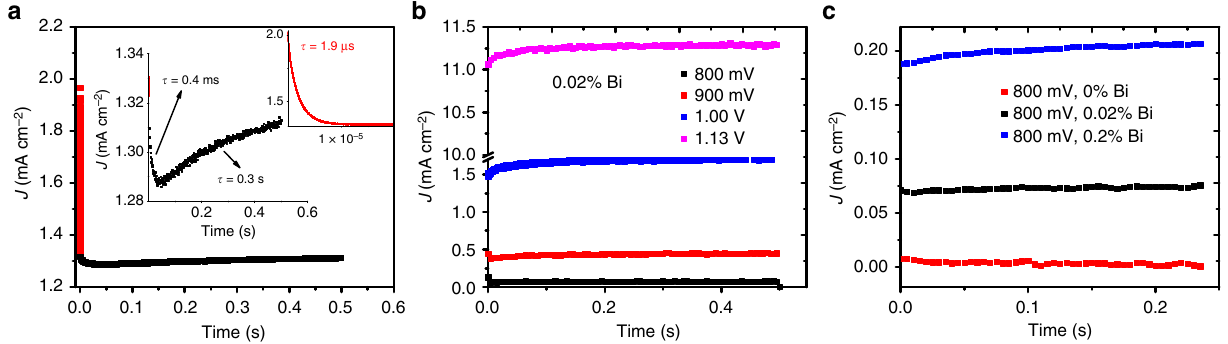
Fig. 4 Transient current response upon applying a voltage step in the dark. a Negative-capacitance device at 0.9 V after applying + 20 mV at time 0. Apart from fast capacitive responses, a transient increase of the current is observed that is the origin of the apparent negative capacitance. b Voltage dependence of the transients of a negative capacitance device. c Comparison of devices with differently pronounced